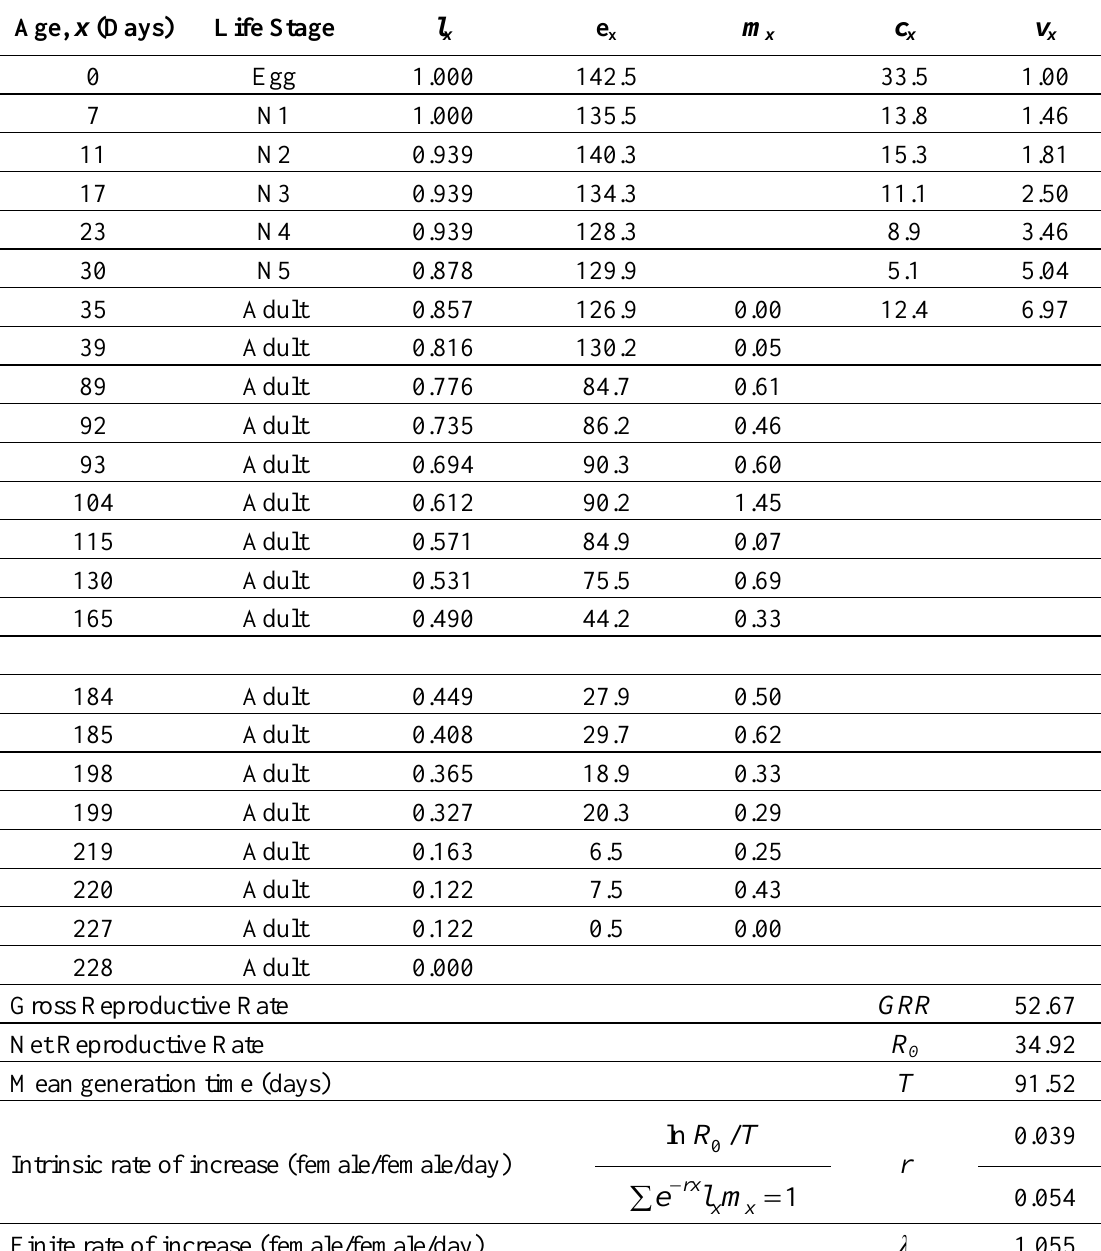
Table 4. Abridged survivorship and fecundity life table, and associated life history parameters, for the pyrethroid-resistant Richmond (RR) field strain of the common bed bug, Cimex lectularius